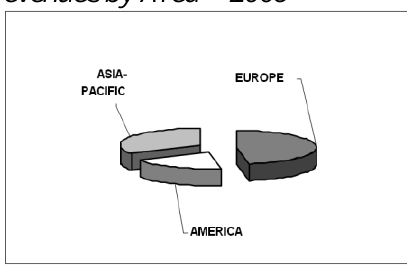
Figure 6: Motor Fuel Revenues by Area –